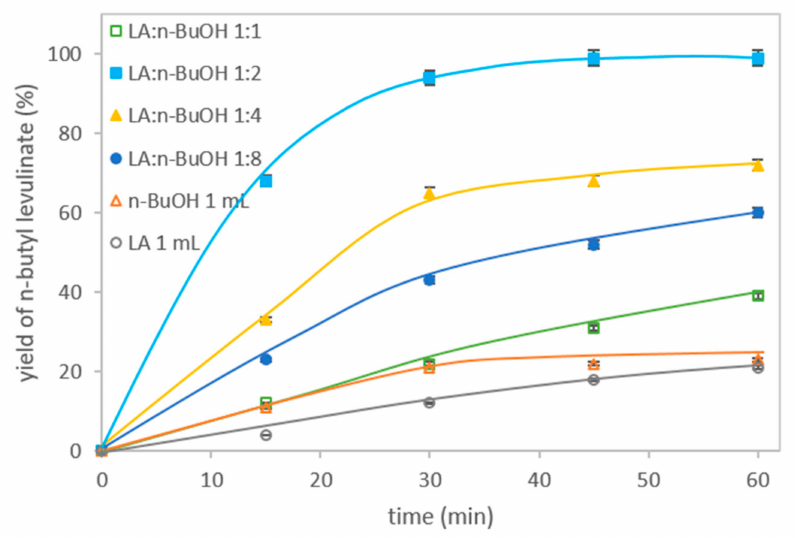
Figure 5. The effect of n -butanol excess on LA esterification. Reaction conditions: LA (0.117 g, 1 mmol or 1 mL of LA); n -butanol (1–11 mmol); CALB/MWCNT-PTFE (0.1 wt.%) biocatalyst (150 mg); cyclohexane (1 mL); 20 ◦ C; 250 rpm.